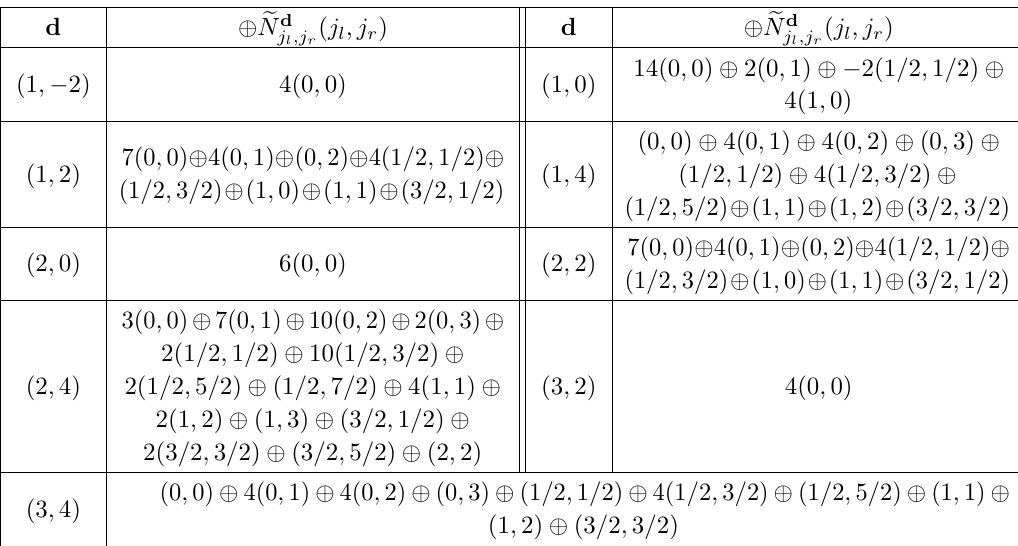
Table 6 . Pseudo-BPS Spectrum of SU(2) Wilson loop expectation value in the representation 2 ⊗ 4 for the curve class d 1 m 0 + d 2 φ with d 1 = 1 , 2 , 3 , and d 2 ≤ 4 . The d 1 = 0 part can be read from (3.58).